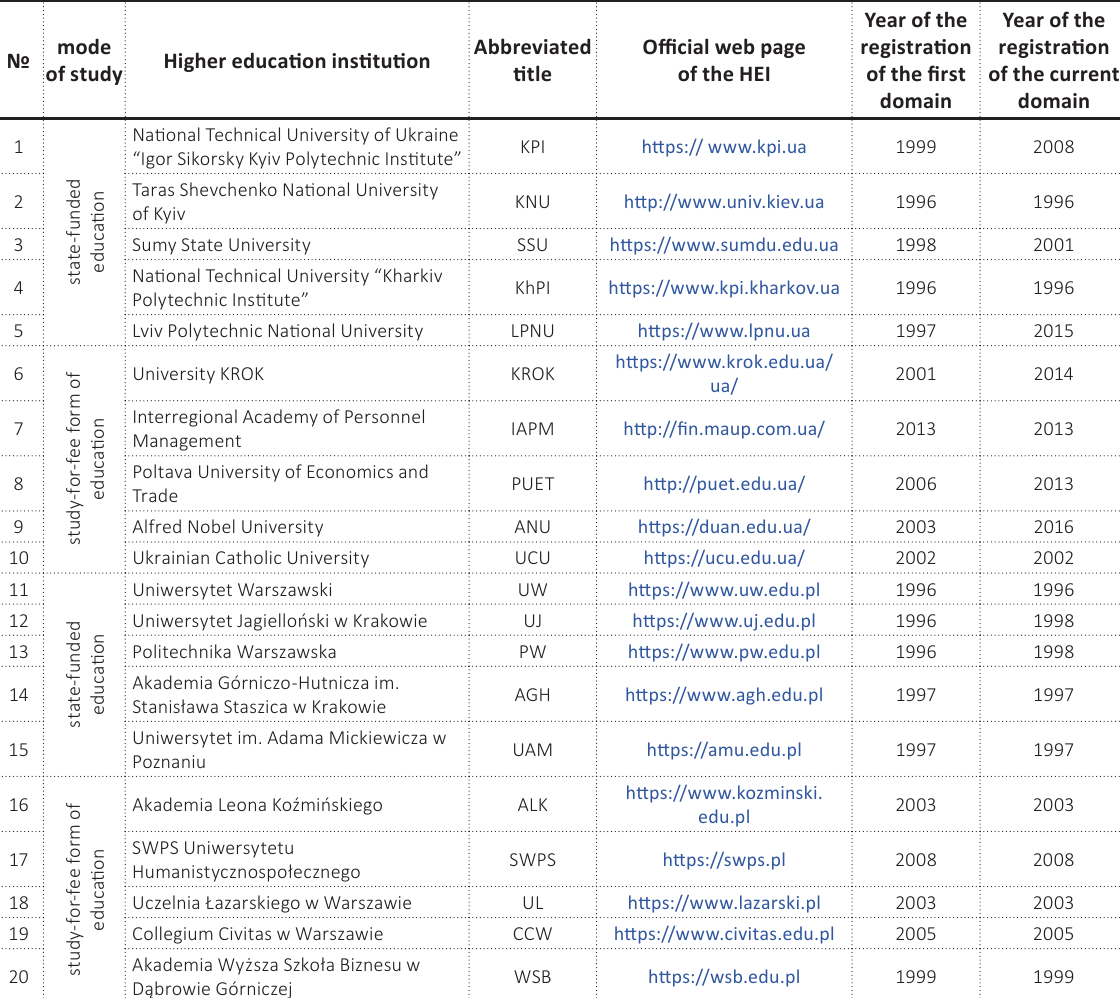
Table 1. List of the selected higher education institutions in Ukraine and Poland and their official web